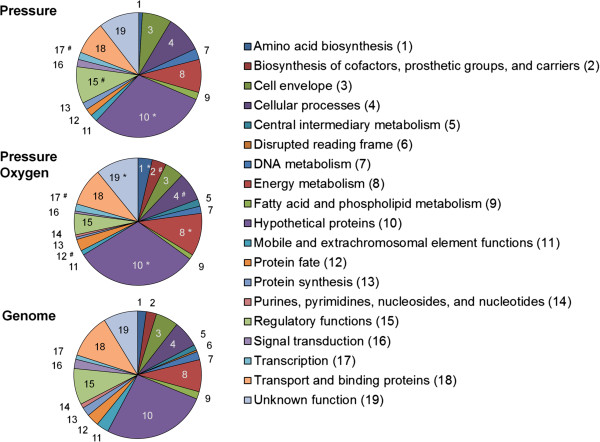
Classification of the significantly differentially expressed genes into role categories. The genes were sorted into the 19 role categories established by the Comprehensive Microbial Resource (CMR). “Pressure” and “Pressure Oxygen” refer to the genes differentially expressed at elevated pressure and at combined elevated pressure and elevated DOT, respectively. For comparison, the gene distribution of the complete P. putida KT2440 genome is also depicted (Genome). For clarity reasons, a number was assigned to each category and is shown in the corresponding sector of the charts. Categories that were significantly over-represented as well as categories containing sub-categories that were significantly over-represented compared to the genome distribution are marked by the asterisk (*) and the hash (#), respectively (for more details, see the Additional file 1: Table S2-S3).